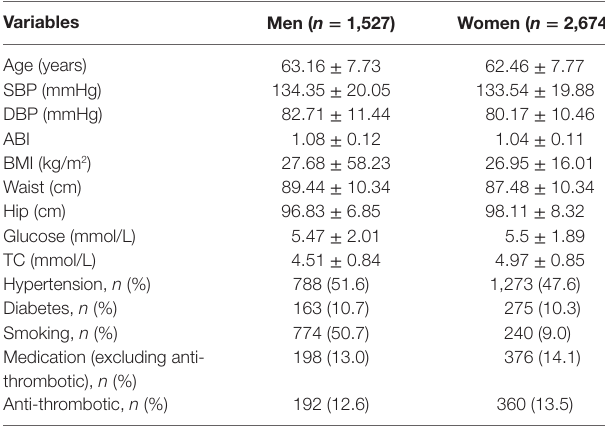
TaBle 2 | Characteristics of study participants at follow-up.